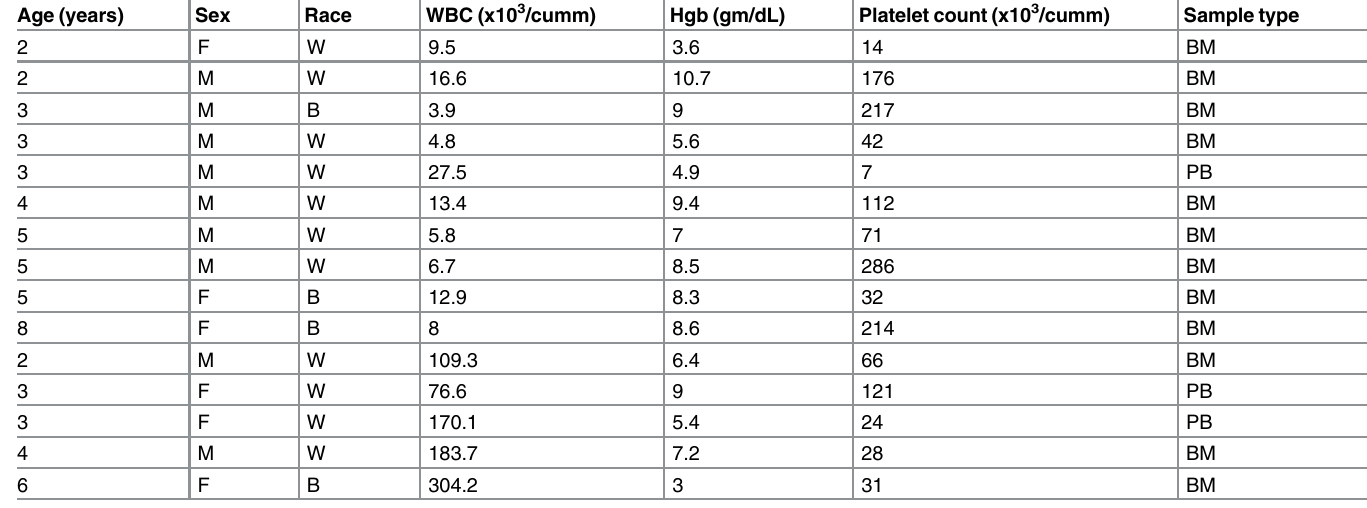
Table 1. ETV6-RUNX1 -positive patient